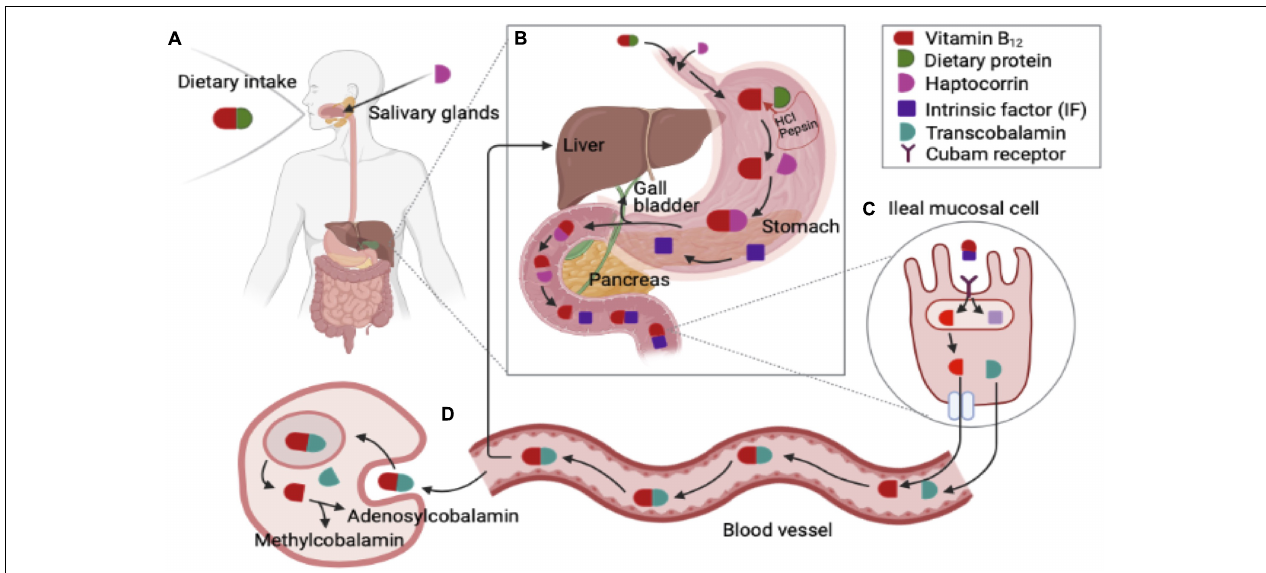
FIGURE 1 | Gastrointestinal metabolisms and enterohepatic circulation of vitamin B12 (Cobalamin) (Modified from Andrès et al., 2004; Stabler, 2013; Hunt et al., 2014; Green et al., 2017; Brito et al., 2018). (A) Dietary vitamin B 12 attach to dietary animal protein produced from salivary gland. (B) Following food-cobalamin intake, dietary protein is released by acidic environment of the stomach via proteolysis, and vitamin B 12 binds to haptocorrin (R-protein) which secreted by salivary glands protecting vitamin B 12 from acid degradation. Pepsin and hydrochloric acid (HCl) from gastric secretion. In stomach, Intrinsic factor (IF) is also secreted, and it binds less strongly when gastric R-protein presents. In duodenum, hatocorrin degradation occurs and the pH is changed in favor of vitamin B 12 binding to IF. Pancreatic enzymes degrade dietary vitamin B 12 and haptocorrin complex to release free vitamin B 12 . Then free vitamin B 12 binds to IF and vitamin B 12 -IF complex transport to ileum. (C) In ileum, IF-vitamin B 12 complex binds/enters to the cubam receptor which consists of cubilin. Cubam receptor mediates endocytosis of IF- vitamin B 12 complex. After the IF and vitamin B 12 detaches, vitamin B 12 binds to transport proteins transcobalamin I, II, and III. Transcobalamin II (TCII) involves transportation of B12 to all cells in the human body. Vitamin B 12 is consequently transported via the portal system. (D) TCII- vitamin B 12 complex is absorbed by endocytosis and free vitamin B 12 is enzymatically converted into its two coenzymatic forms including methyl-cobalamin (Me-Cbl) and adenosyl-cobalamin (Ado-Cbl). Most of vitamin B 12 stored in the river and some of vitamin B 12 is secreted in bile, which undergoes enterohepatic